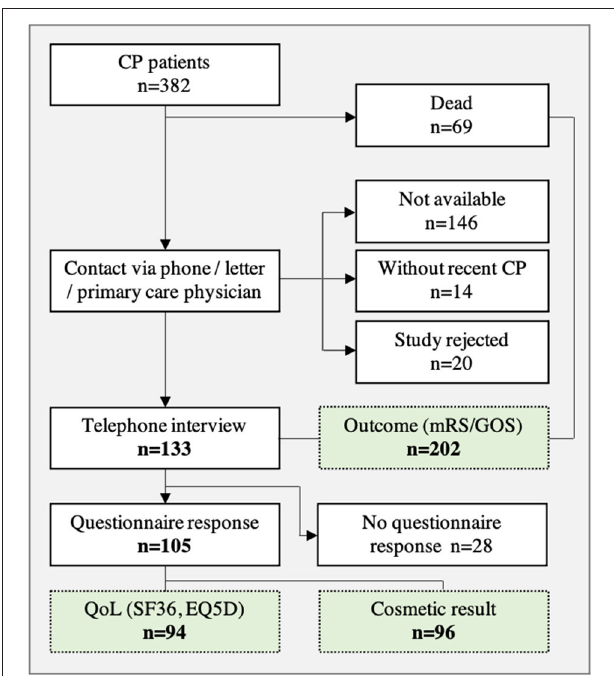
FIGURE 1 | Patient collective after CP surgery and follow-up analysis